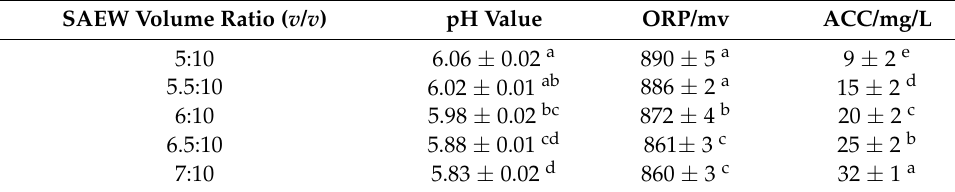
Table 1. Specific parameters of slightly acid electrolyzed